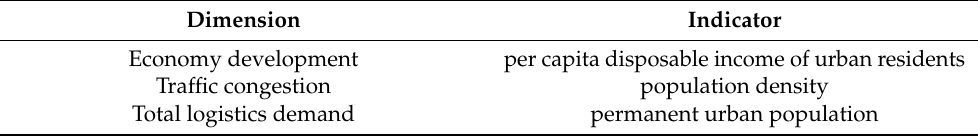
Table 1. The indicator composition of the logistics-level